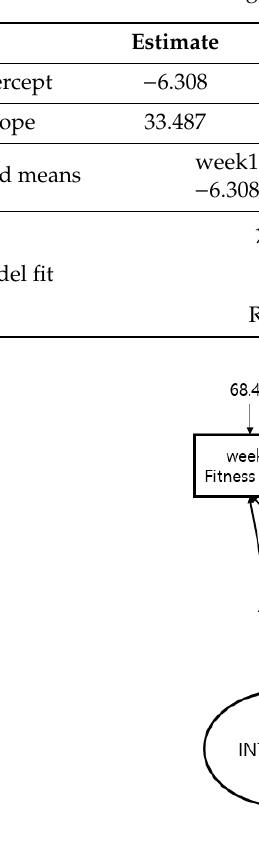
Table 4. Changes in fitness scores per measurement period.